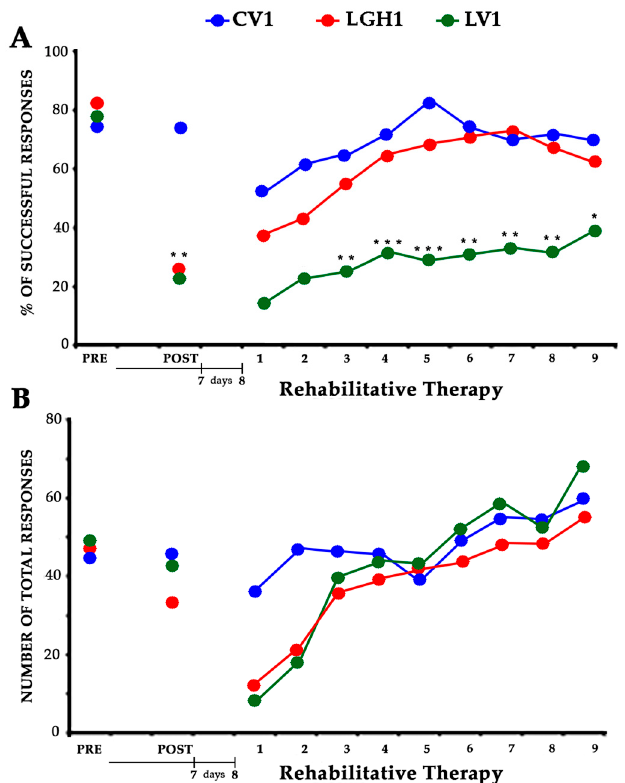
Figure 1. E ff ectiveness of the treatment with GH and rehabilitation. Animals treated with GH (LGH1, red graph) or vehicle (LV1, green graph) immediately after cortical ablation. Results obtained in the paw-reaching-for-food task with the preferred paw (impaired paw) at the presurgical phase, (PRE), 7 dpi (days post-injury) (POST) and rehabilitative therapy (at 8 dpi). ( A ) Mean percentage of successful responses (successful responses / total number of responses). ( B ) Mean of the total number of responses (successful plus unsuccessful with both paws). The rehabilitative therapy consisted in the obliged use of the impaired paw, in daily sessions of 3 min for nine consecutive days. Significance levels are done with respect to the sham-operated control group (CV1, blue graph). *** p < 0.001; ** p < 0.005; * p < 0.01 (Bonferroni test). The x-axis indicates days.